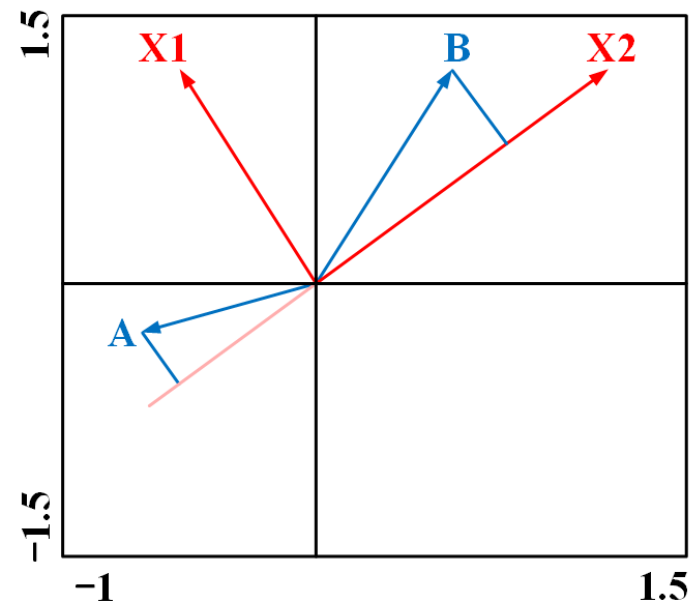
Figure 5. Biplot of RDA. We can approximate the correlation between the response variables ( A , B ) and an explanatory variable (X2) by a perpendicular projection of the species arrow tips ( A , B ) onto the line overlaying the environmental variable arrow (X2). The further a projection point falls in the direction indicated by the arrow, the higher the correlation, with a projection point near the coordinate origin (zero point) suggesting no correlation. If the projection point lies in the opposite direction ( A ), the predicted correlation is negative. A similar, but less precise interpretation can be based on the angle between the two compared arrows. The statistics were carried out using the R vegan packages.